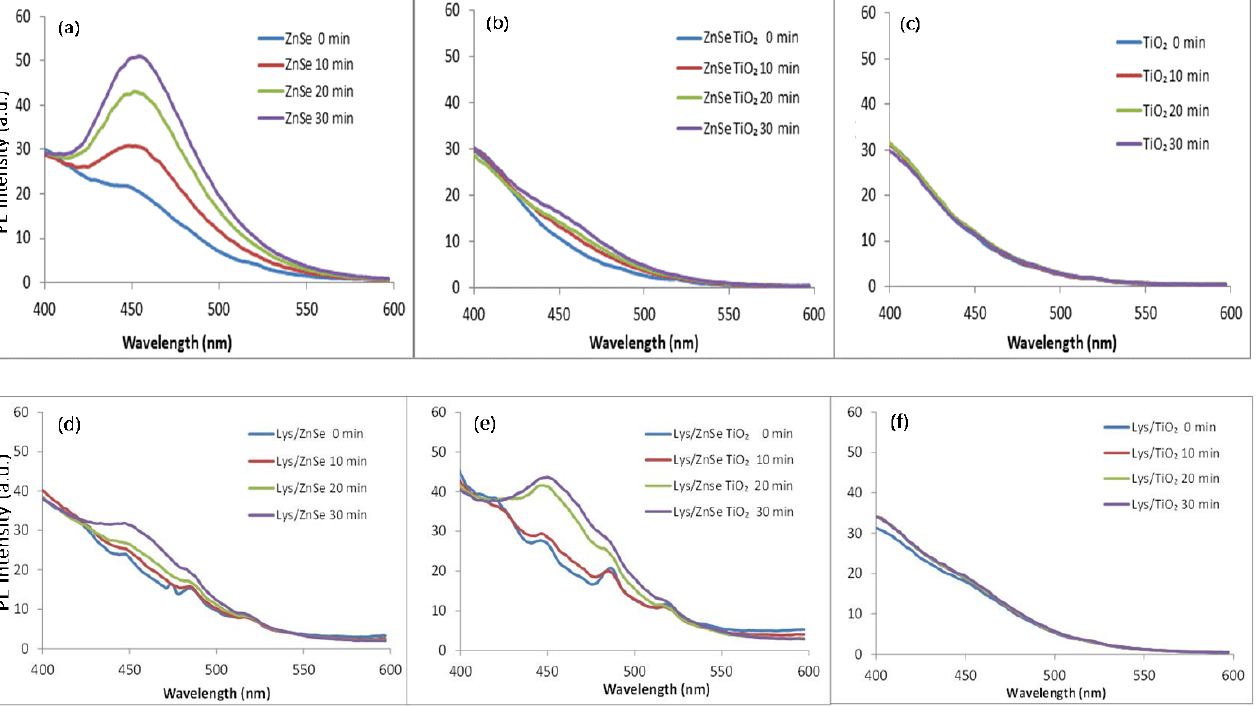
Figure 18. The time course of O 2• − formation over inorganic ( a – c ) and lysozyme modified samples ( d – f ) under visible light irradiation. For the lysozyme modified samples, a well-defined characteristic band with a maximum at 470 nm is displayed in the case of Lys/ZnSe-TiO 2 and Lys/ZnSe. This certi-